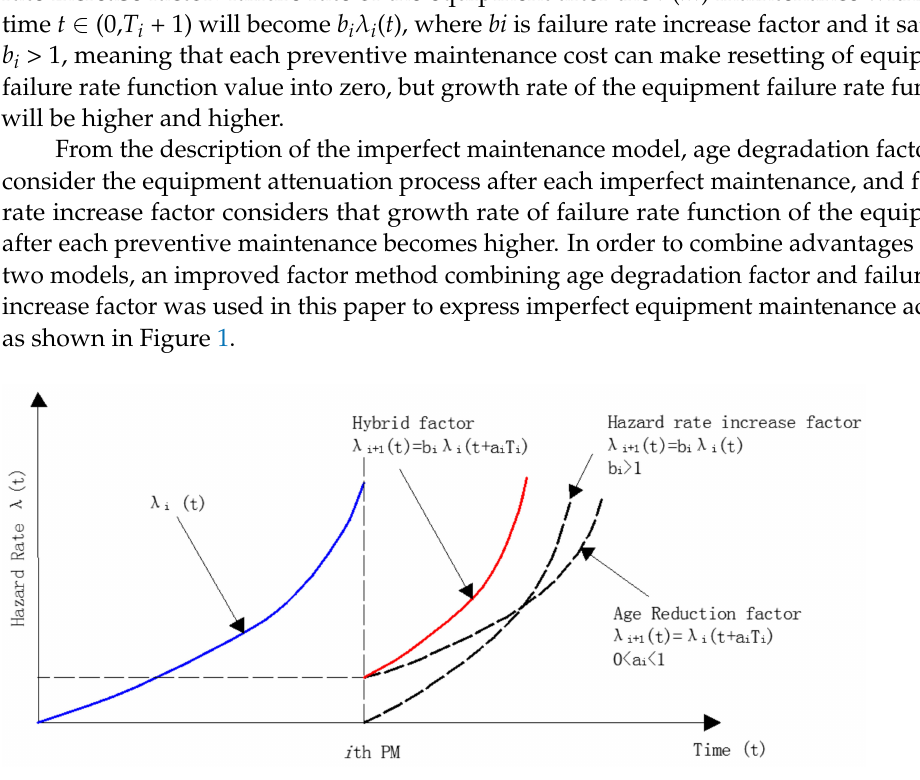
Figure 1. Improvement factor model for component failure